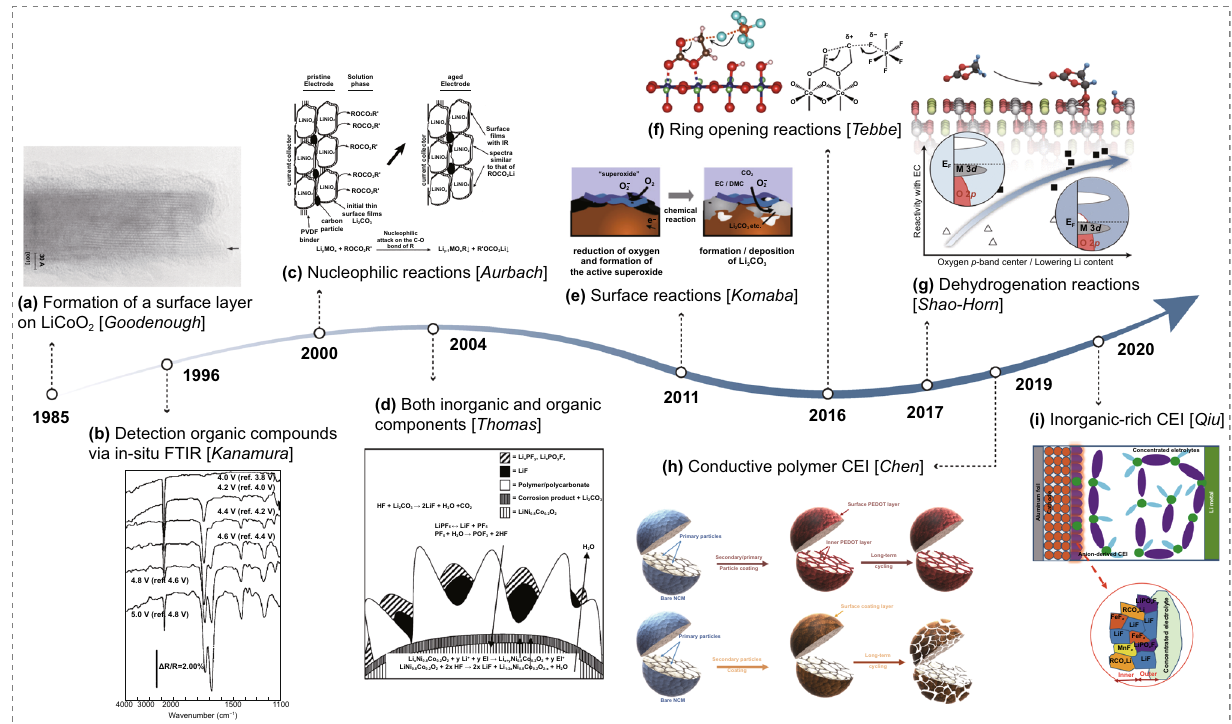
Fig. 1 A brief historic evolution of CEI on positive electrodes. a Formation of a surface layer on LiCoO 2 was first suggested by Goodenough et al. early in 1985. Copyright from Ref. [29]. b Kanamura et al. detected carboxylate species using in situ FTIR. Copyright from Ref. [30]. c Nucleophilic reactions mechanism was proposed by Aurbach for nucleophilic cathodes. Copyright from Ref. [28]. d The compositions of the CEI layer are further identified from XPS results. Copyright from Ref. [31]. e Surface reaction mechanism of the formation of Li 2 CO 3 . Copy- right from Ref. [39]. f Ring-open reaction of ethylene carbonate. Copyright from Ref. [42]. g Dehydrogenation reaction on the cathode surface. Copyright from Ref. [44]. h Illustration of the structural stability of artificial conductive polymer CEI. Copyright from Ref. [32]. i Schematic of LiF-rich CEI formed in the concentrated electrolyte. Copyright from Ref.